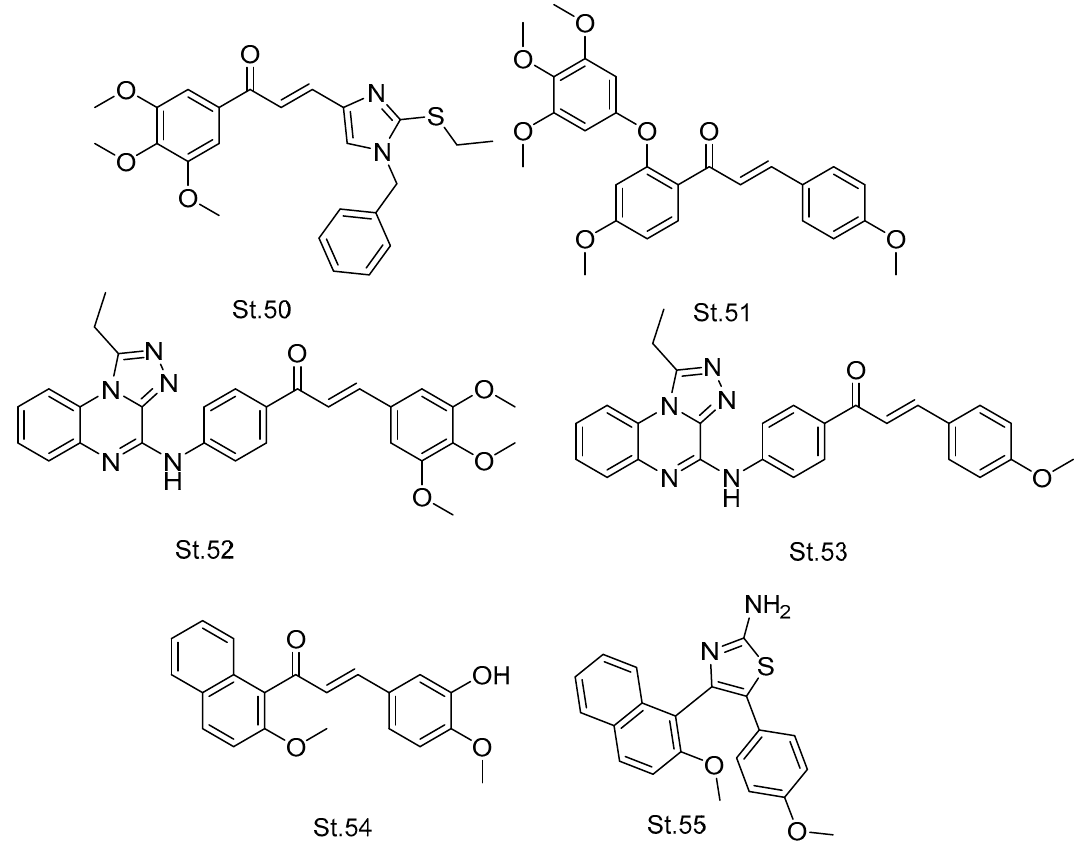
Figure 10. The structures of chalcone